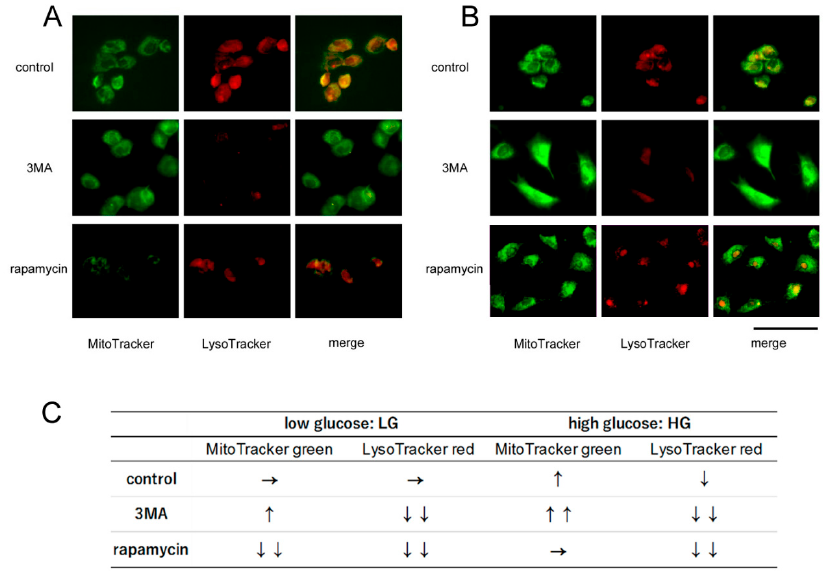
Figure 2. Cytological assessments of mitophagy. Representative photomicrographs using MitoTracker green ® and LysoTracker red ® dyes of 661 W cells cultured under low glucose ( A ) and high glucose ( B ) conditions. Mitochondria (green) and lysosomes (red) are made visible by these dyes respectively, and their colocalization is shown. Rapamycin, an inducer of autophagy, decreased the intensity of MitoTracker green fluorescence under LG condition indicating mitochondrial digestion ( A , bottom), while this e ff ect was almost absent under HG condition ( B , bottom). The intensity of the MitoTracker green fluorescence appeared to be increased by an addition of 3MA, an inhibitor of autophagy under HG conditions ( B , middle), while the increase in the intensity appeared to be modest under LG conditions ( A , middle). These findings suggest mitochondrial digestion is enhanced by rapamycin in LG condition and is depressed by 3MA in HG conditions (bar = 100 µ m). ( C ) Qualitative assessment of mitophagy using fluorescence probes under each condition. Upward and downward arrows indicate an increase or decrease in the